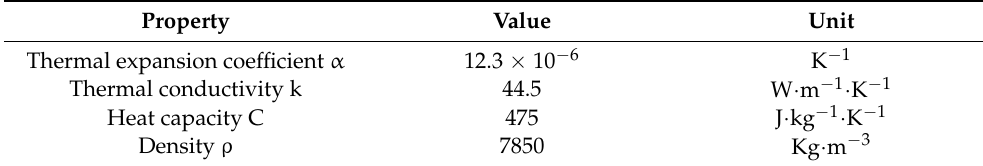
Table 1. Material properties of the steel model.